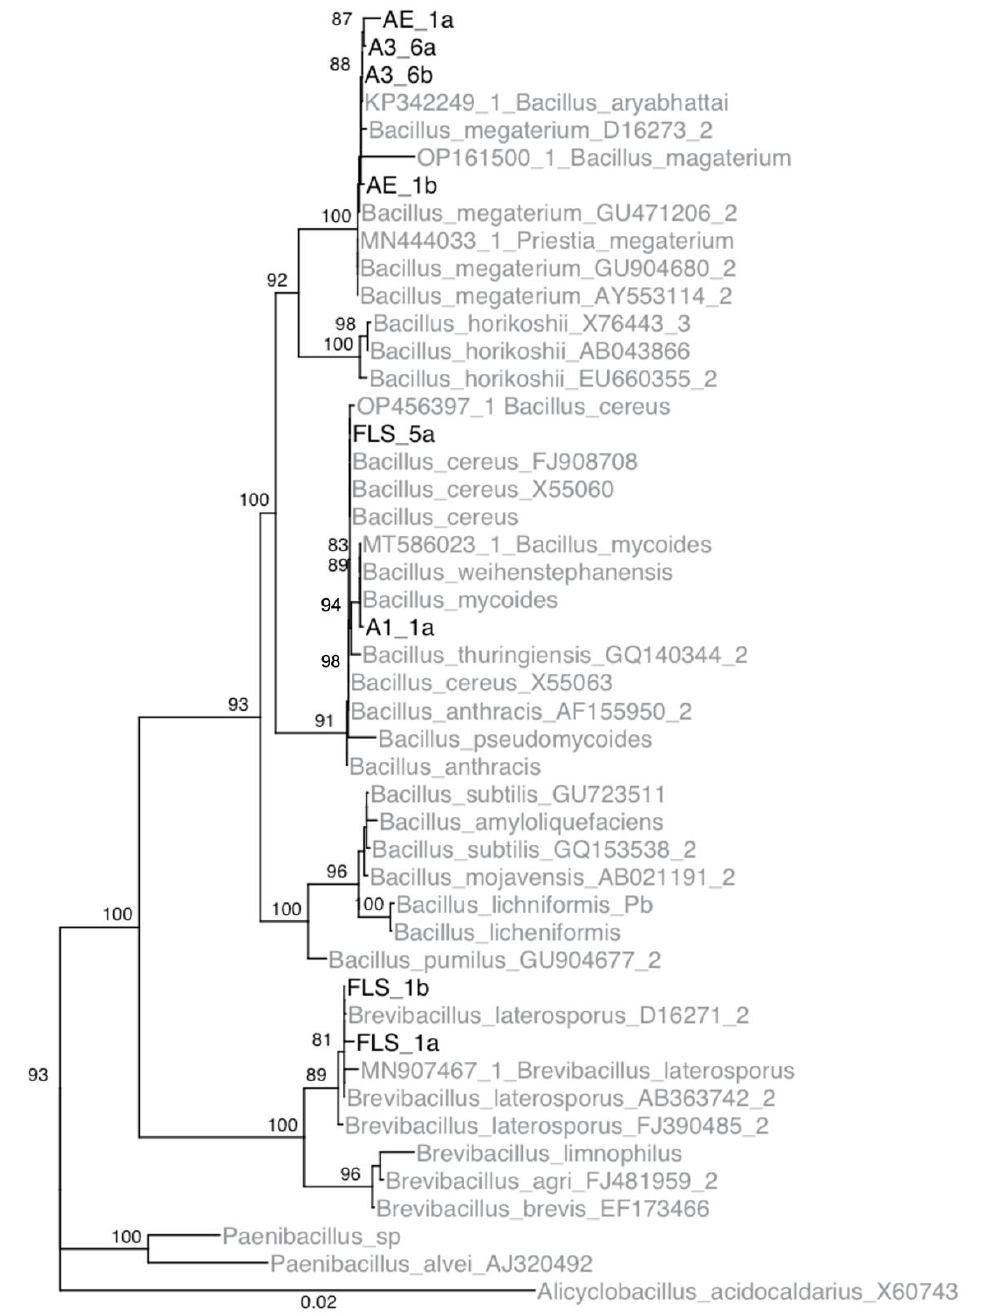
Figure 2. Inferred IQTree ultrafast bootstrap (UFBoot) of the isolates collected from Pennsylvania and type strains of Bacillus species based on 16S rDNA sequences. Numbers located at each node are bootstrap values. Note, bootstrap values below 80 are not shown on the tree. Isolates from this study are shown in black, and isolates obtained from GenBank are in gray.